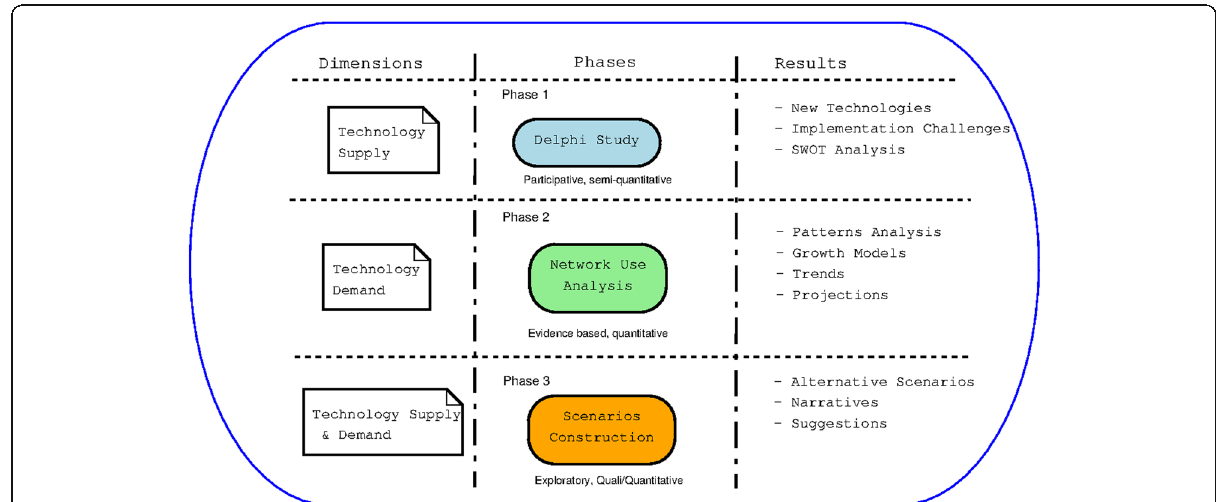
Fig. 1 Methodological scheme of the